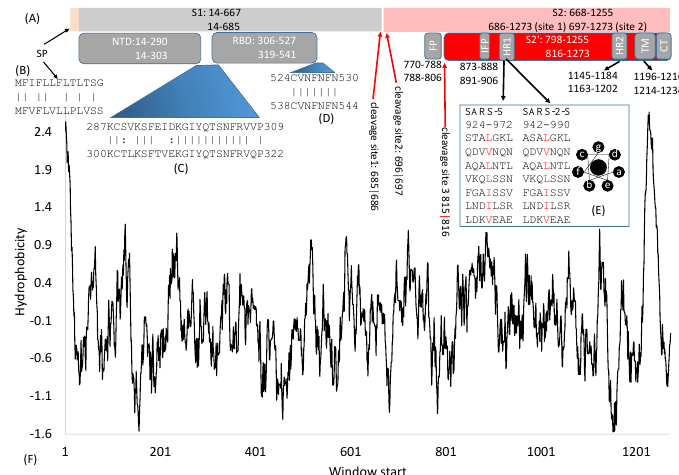
Figure 1. Domain structure of SARS-S and SARS-2-S. ( A ) Key domains in SARS-S and SARS-2-S. SP, signal peptide; NTD, N -terminal domain; RBD, receptor-binding domain; FP, fusion peptide; IFP, internal fusion peptide; HR, heptad repeats; TM, transmembrane domain; CT, cytoplasmic tail. The top and bottom numbers in each domain pertain to SARS-S and SARS-2-S, respectively. The red arrows indicate cleavage sites, and their numbers pertain to SARS-2-S; ( B ) Alignment of SP between SARS-S (top) and SARS-2-S (bottom); ( C , D ) Alignment of two inter-domain segments; ( E ) HR1 in SARS-S and SARS-2-S, together with the top view of a helix showing hydrophobic positions a and d on the same side; ( F ) Hydrophobicity plot generated from DAMBE [16].